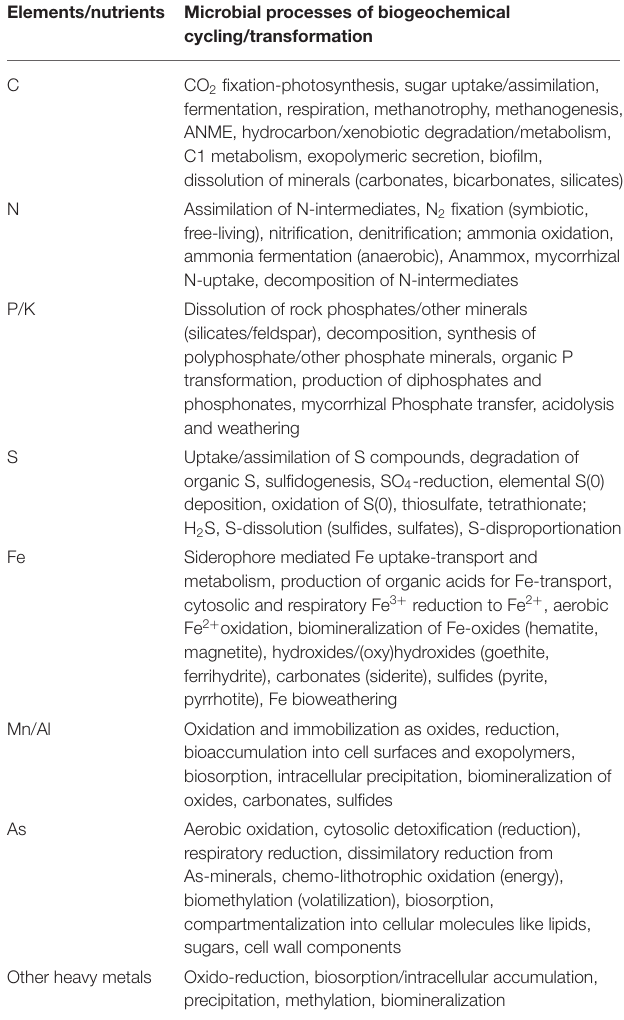
TABLE 3 | Major role of PGP microbes in elemental transformation and nutrient cycling processes. Elements/nutrients Microbial processes of biogeochemical